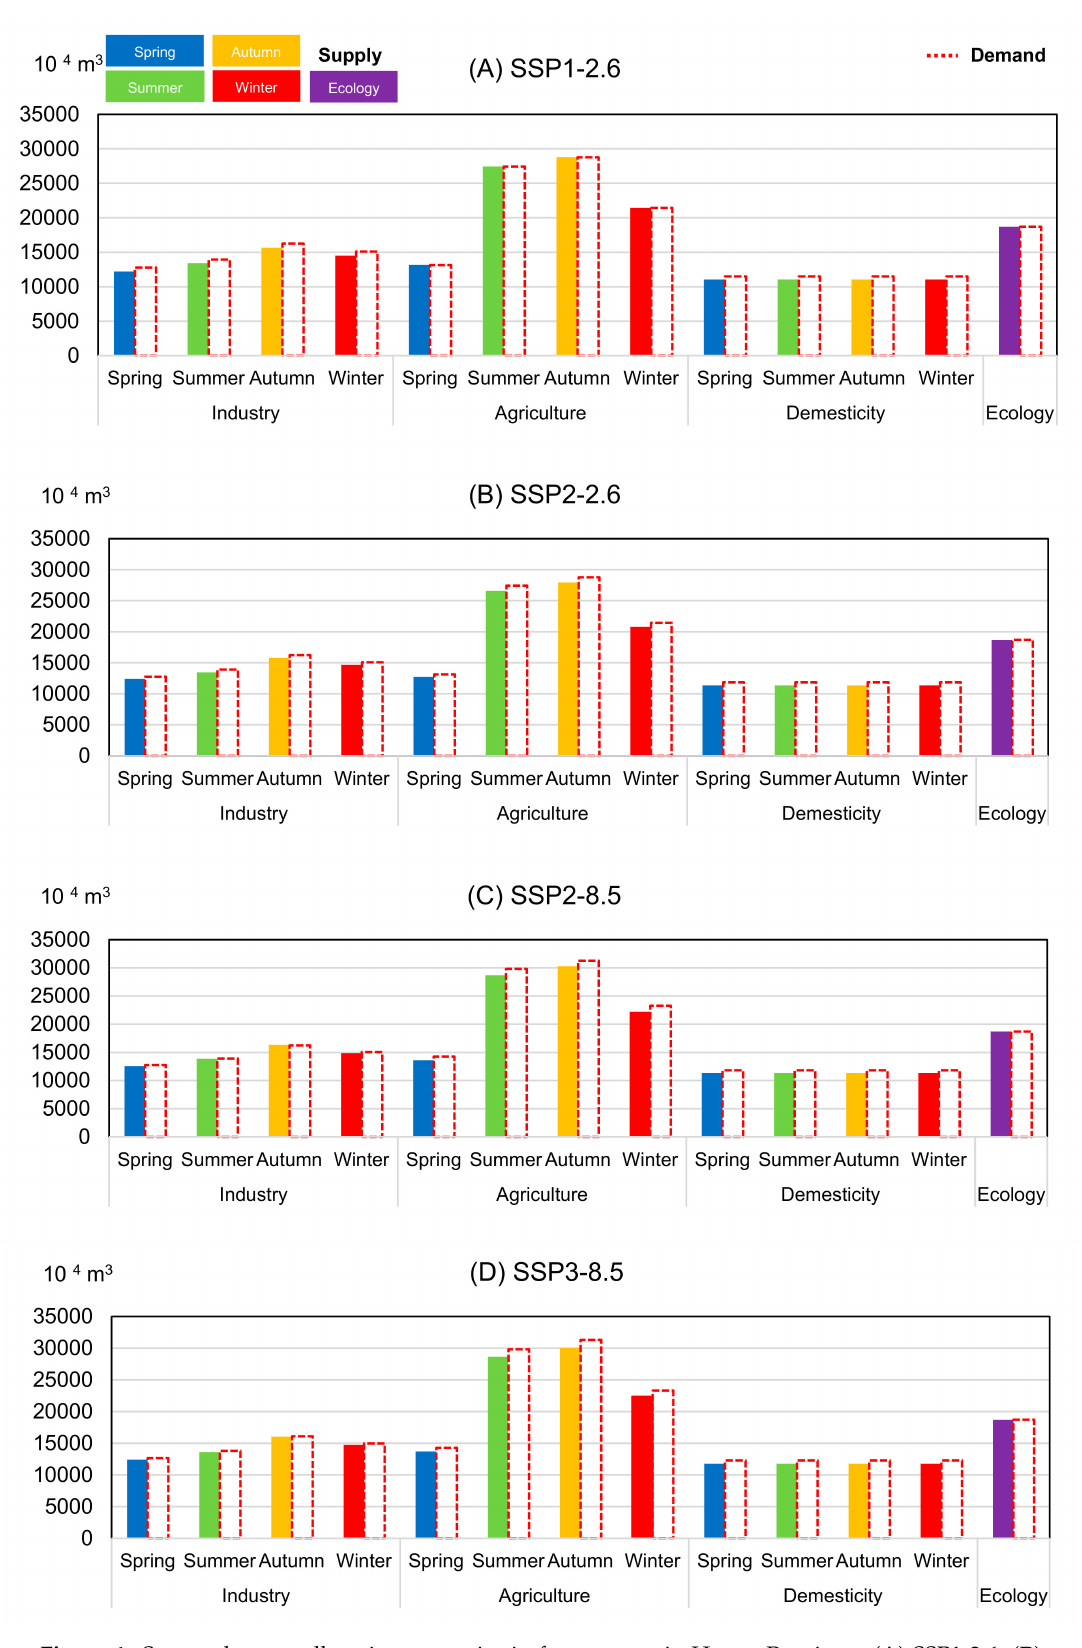
Figure 4. Seasonal water allocation strategies in four sectors in Henan Province. ( A ) SSP1-2.6; ( B ) SSP2-2.6; ( C ) SSP2-8.5; ( D )